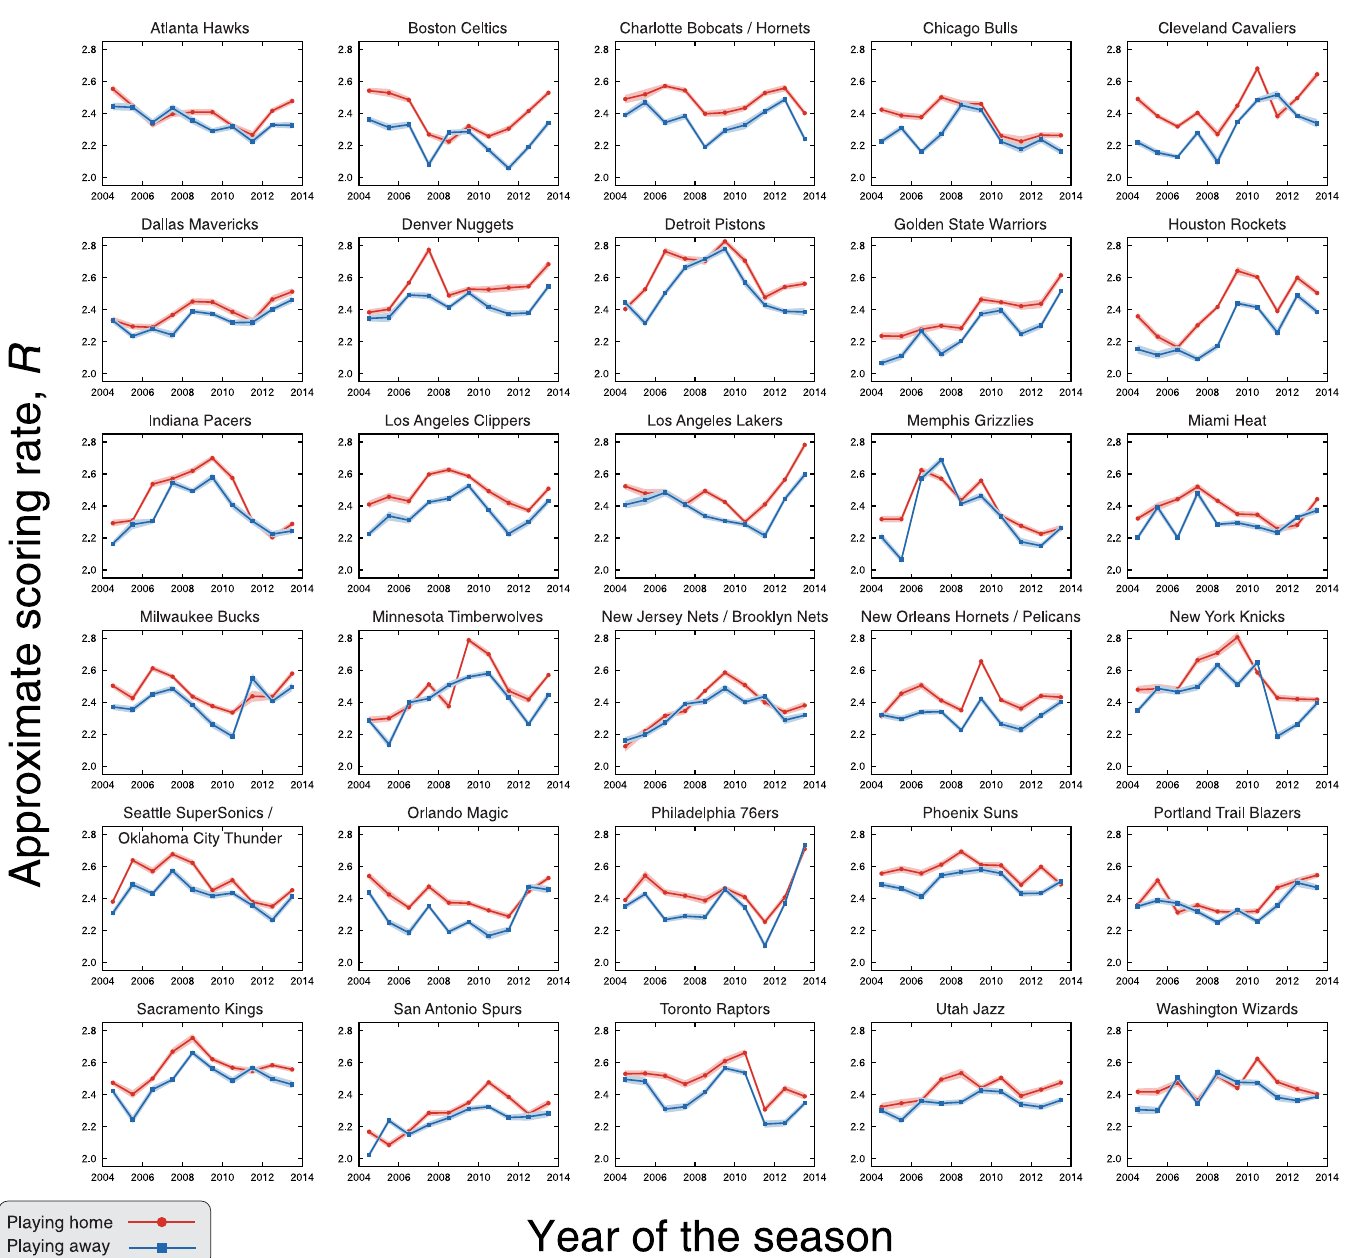
Fig 3. Evolution of the scoring rate when playing home and away for each NBA team. The panels show the approximate scoring rates R when playing home (red circles) and away (blue squares) for every team and season from 2004 – 05 to 2013 – 14, period in which the teams were the same. The shaded areas are 95% bootstrap confidence intervals. Notice that the scoring rates are systematically larger when the team plays home; however, we do observe some inversions and that values of R vary among teams and